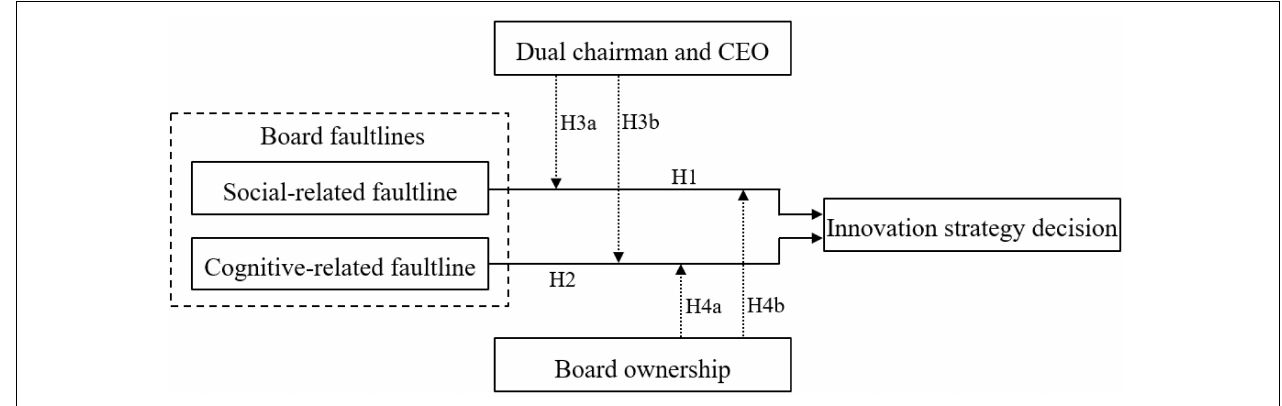
FIGURE 1 | Conceptual